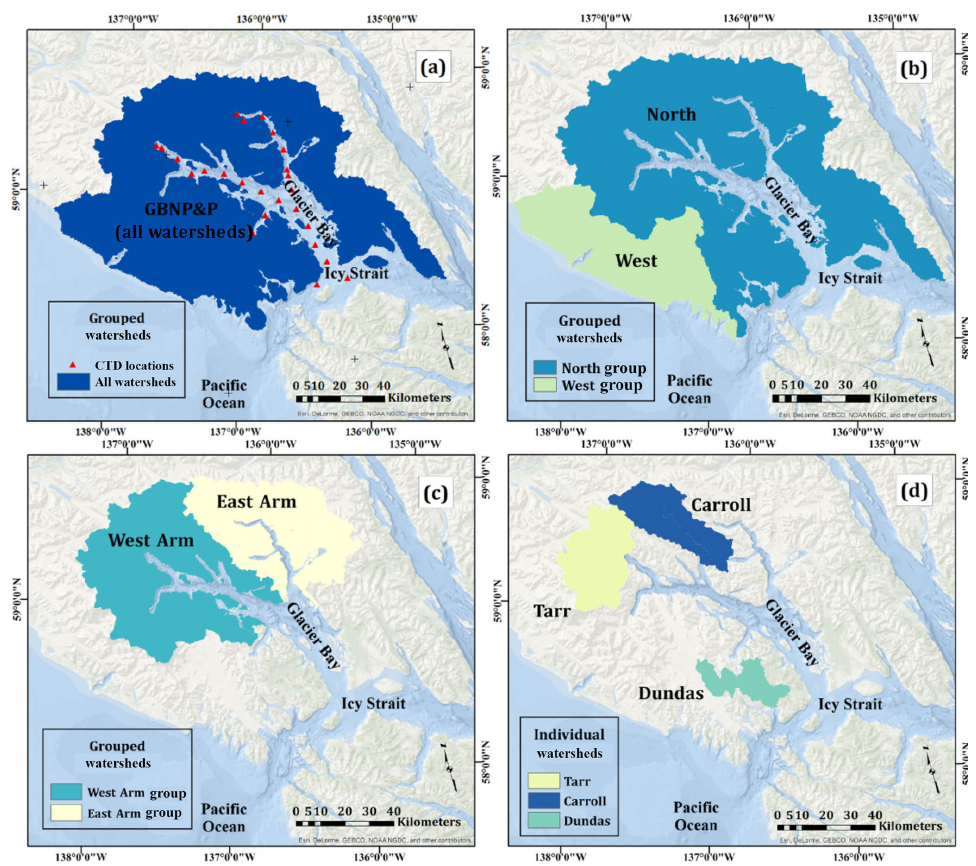
Figure 2. Watershed maps. (a) All watersheds in the GBNPP group and the locations of the CTD casts (discussed in Sect. 3.3). (b) North and West grouped watersheds. The North delivers freshwater to the main stem of Glacier Bay, and the West delivers water to the Pacific Ocean. (c) The upper-bay grouped watersheds that deliver freshwater to the East Arm and West Arm of Glacier Bay. (d) The three individual watersheds: Tarr, Carroll, and Dundas. Table 1. Key physical characteristics of the 8 sub-watersheds in the study